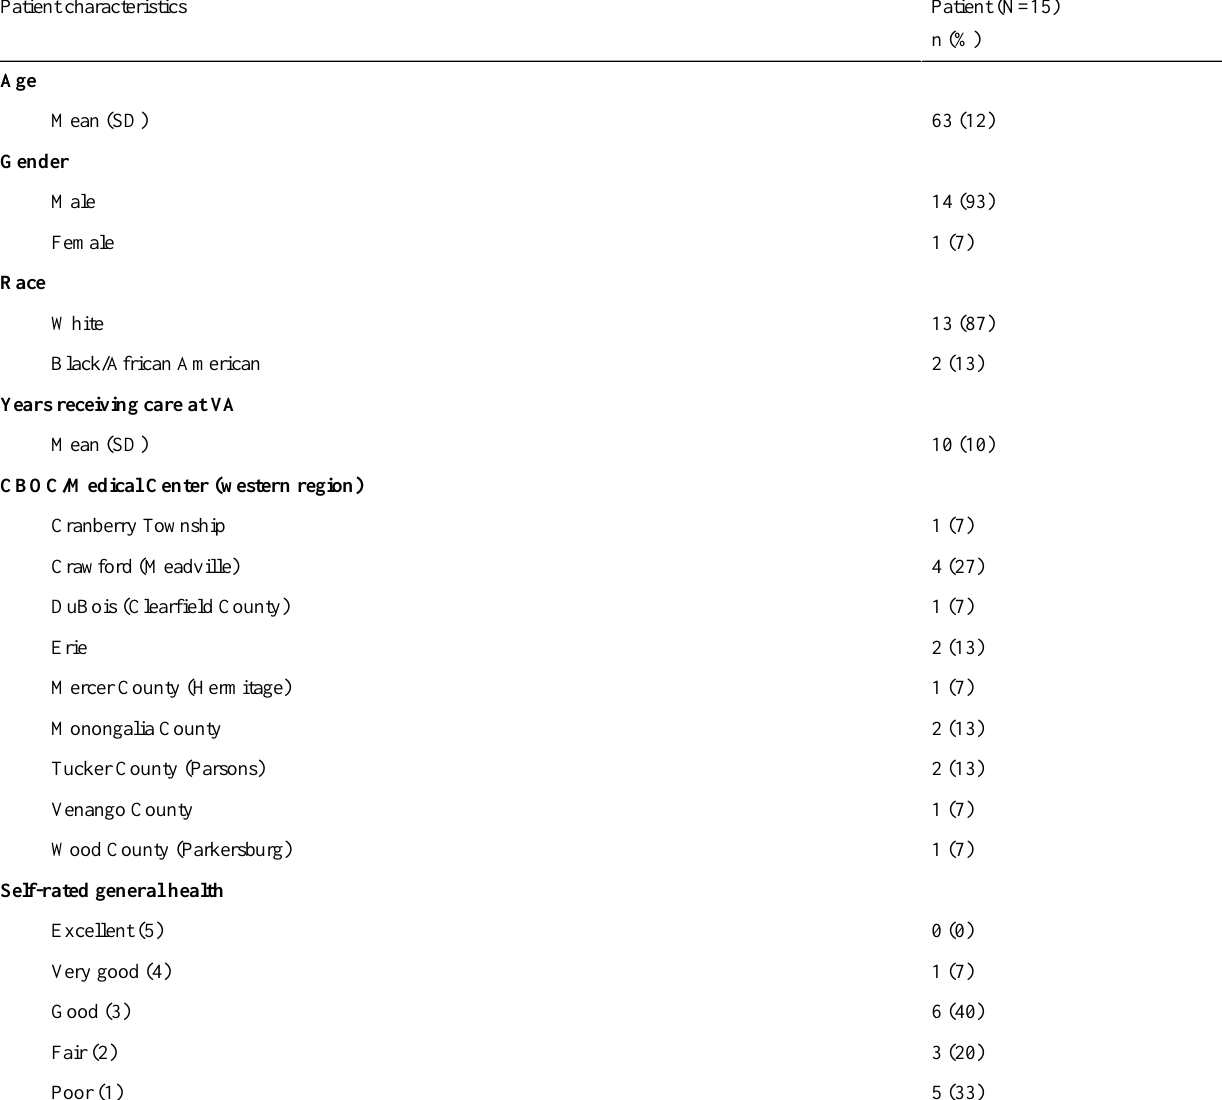
Table 1. Patient